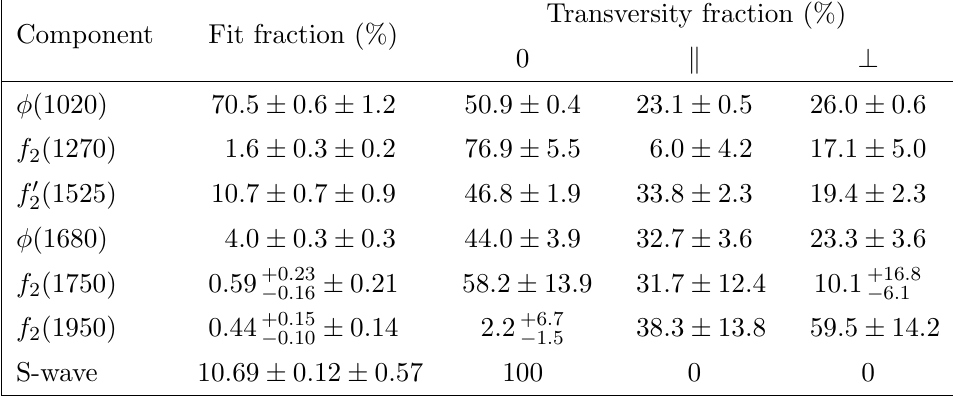
Table 3 . Fit results of the resonant